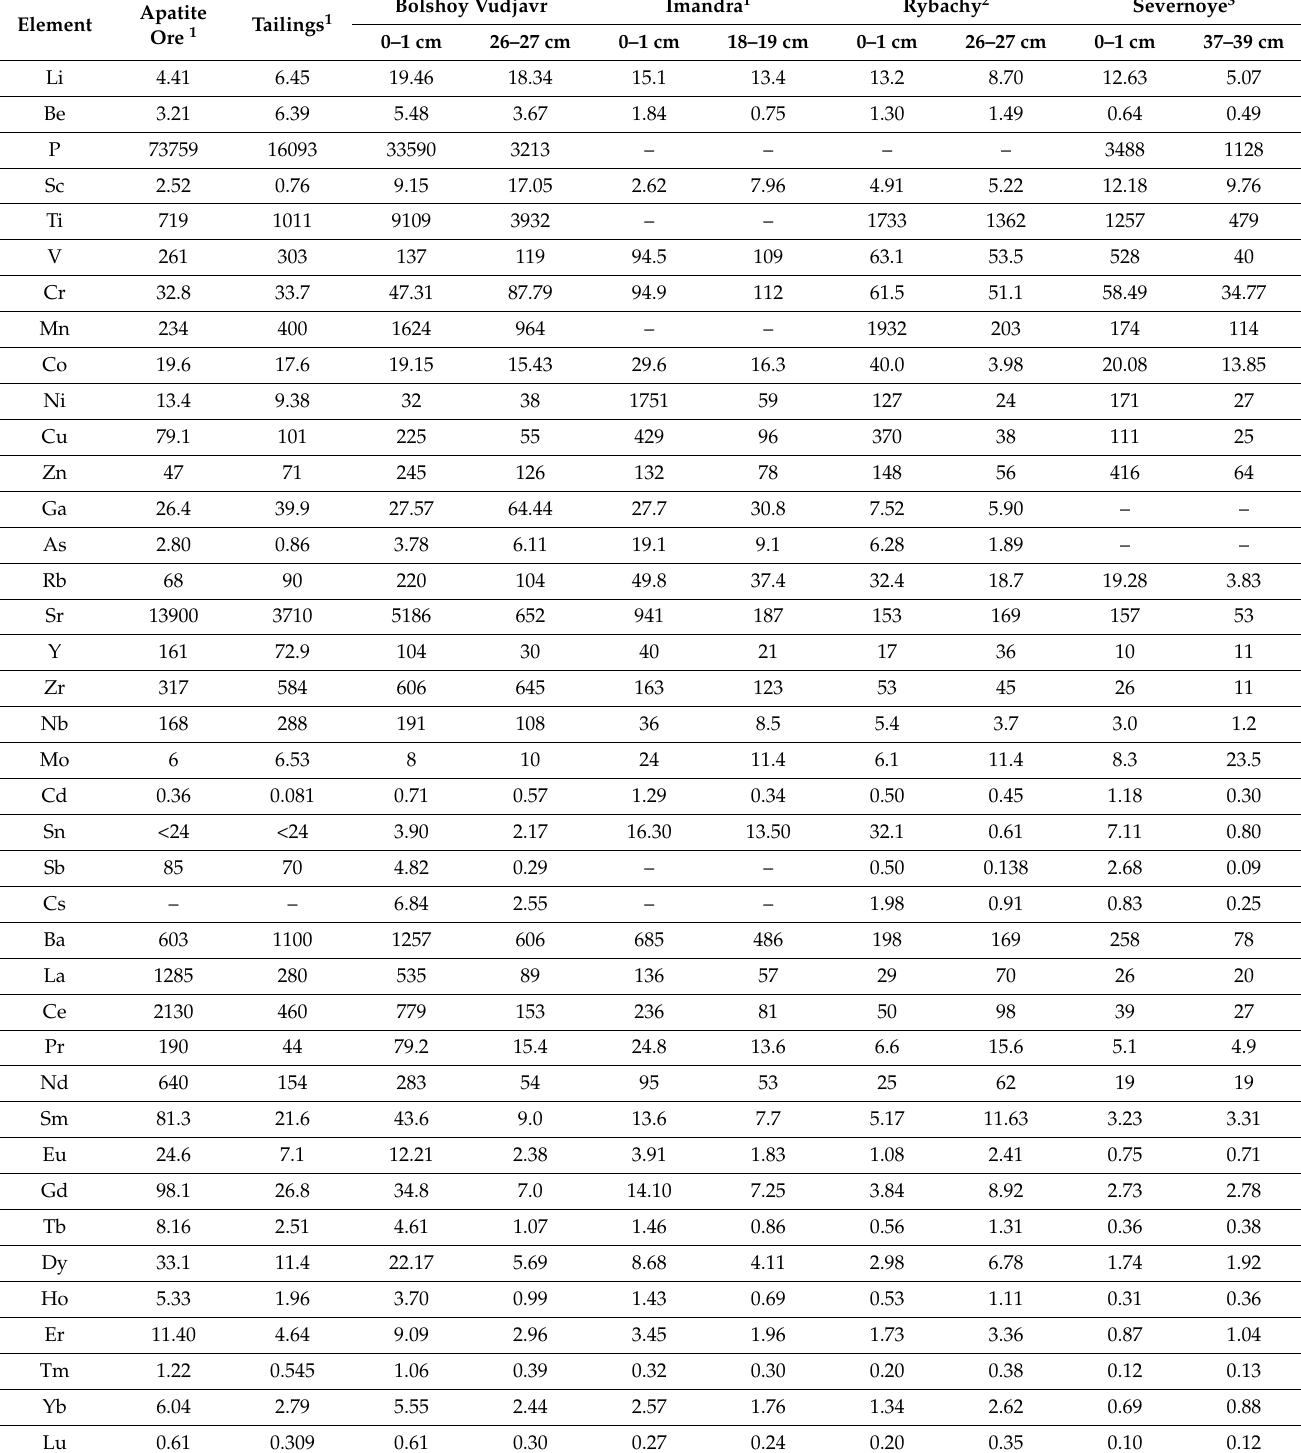
Table 2. The content of trace elements (in µ g/g) in apatite ore, tailings of apatite production, and surface and background layers of sediments of lakes Bolshoy Vudjavr, Imandra, Rybachy, and Severnoye according to the results of mass spectrometry with inductively coupled plasma